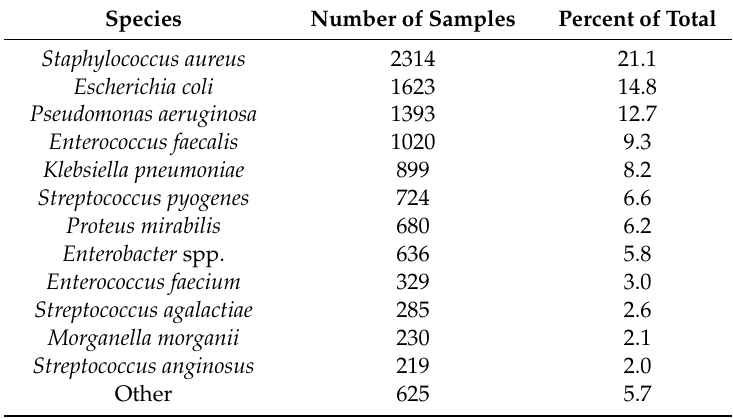
Table 1. Bacterial species isolated from infected decubitus ulcers, leg ulcers and surgical wounds.